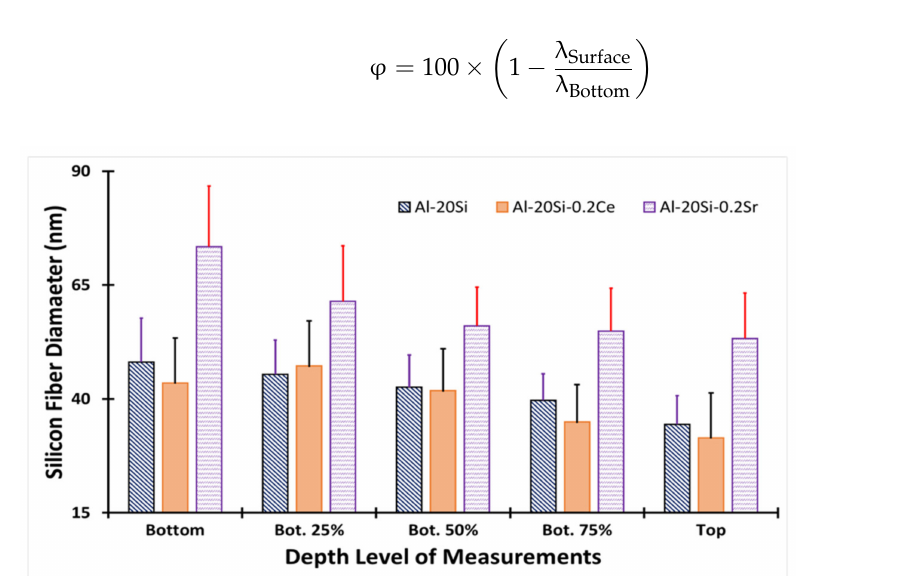
Figure 8. General overview of Si fiber refinement for the three alloys. Errors are represented in 1 stan- dard deviation. Refinement level ( φ ) is calculated to be 28.4% for Al-20Si, 27.7% for Al-20Si-0.2Ce and 27.5% for